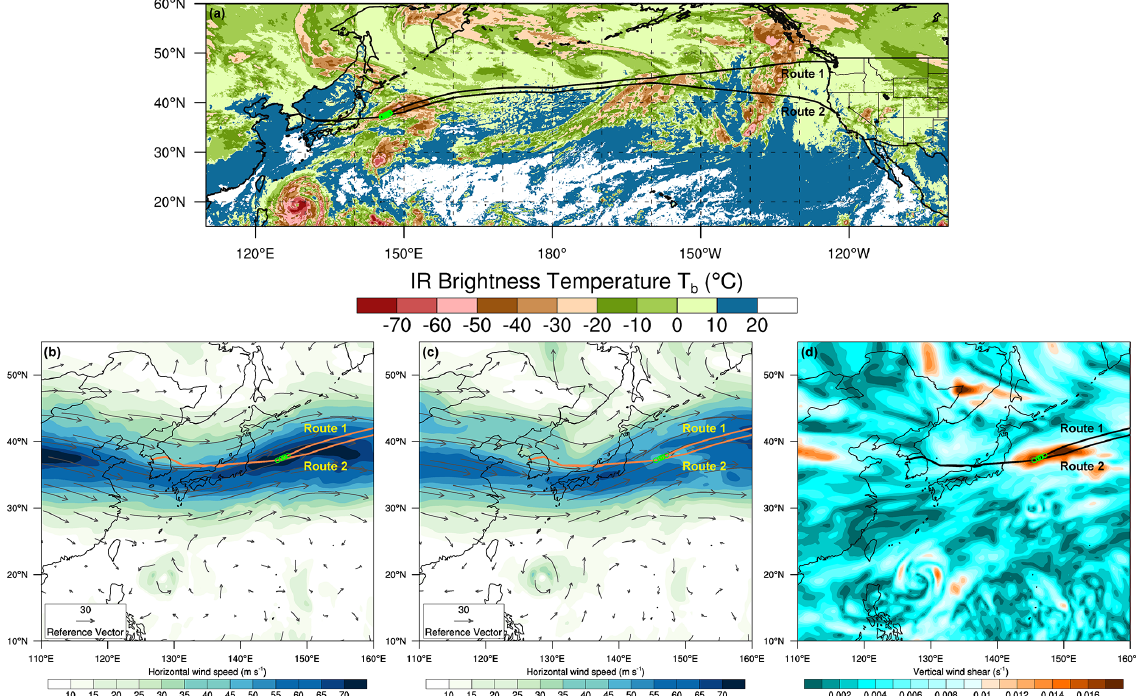
Figure 12. (a) Observed infrared brightness temperature and (b, c) horizontal wind speed (shading) and wind vector (curly arrow) at 200 and 250hPa, respectively, and (d) vertical wind shear at 225hPa computed from the ERA-5 reanalysis data at 12:00UTC on 11 October 2012. The flight routes (line) and horizontal locations (circle) of MOG-level turbulence events from two QAR datasets (routes 1 and 2: from 09:42 to 18:36UTC and from 08:30 to 17:42UTC, respectively) are superimposed.